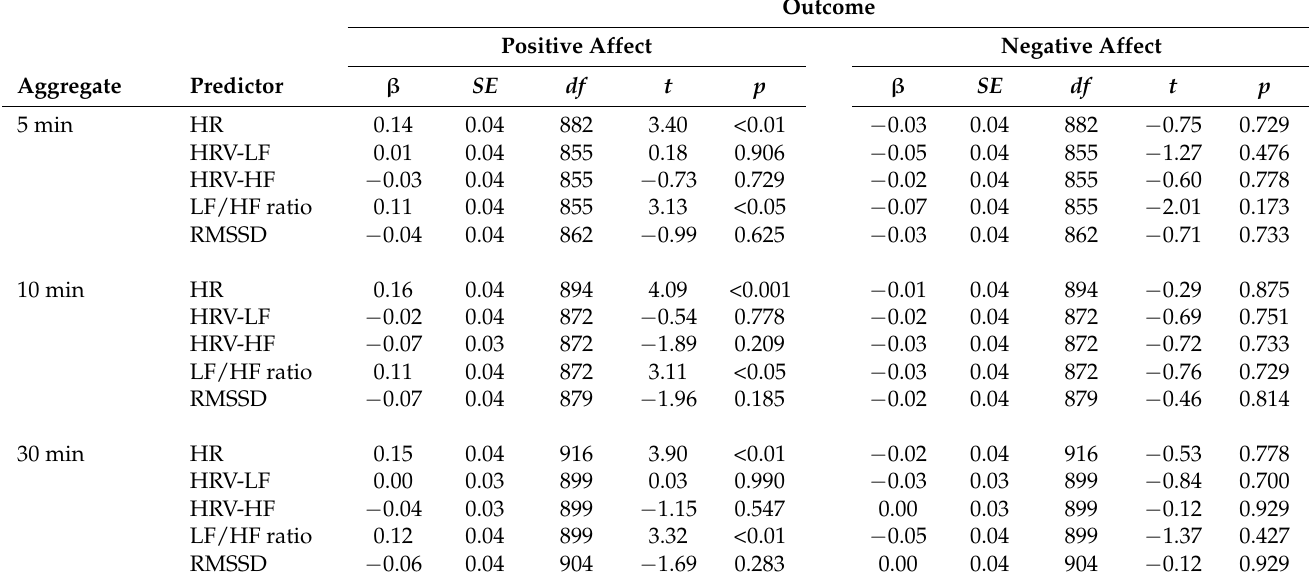
Table 4. Within-individual associations of HR and HRV parameters in different epoch lengths before filling out the ESM questionnaires with positive and negative affect sum scores controlling for body position and activity